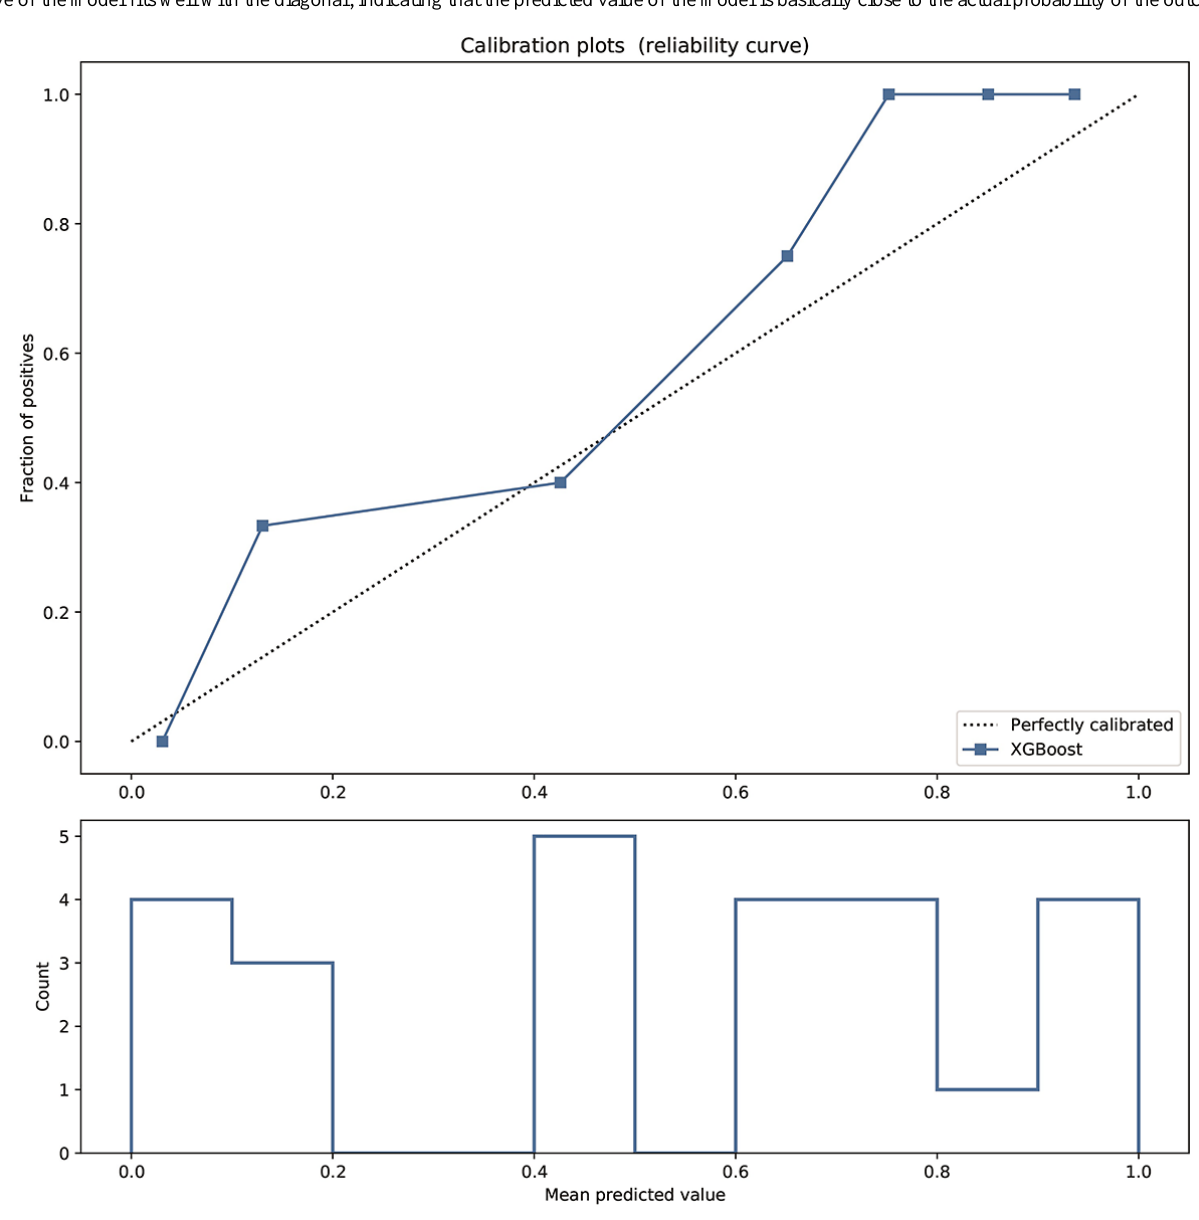
Figure 6. Calibration curve reflecting the degree of consistency between the predicted risk and the actual risk of the XGBoost model. The predicted curve of the model fits well with the diagonal, indicating that the predicted value of the model is basically close to the actual probability of the